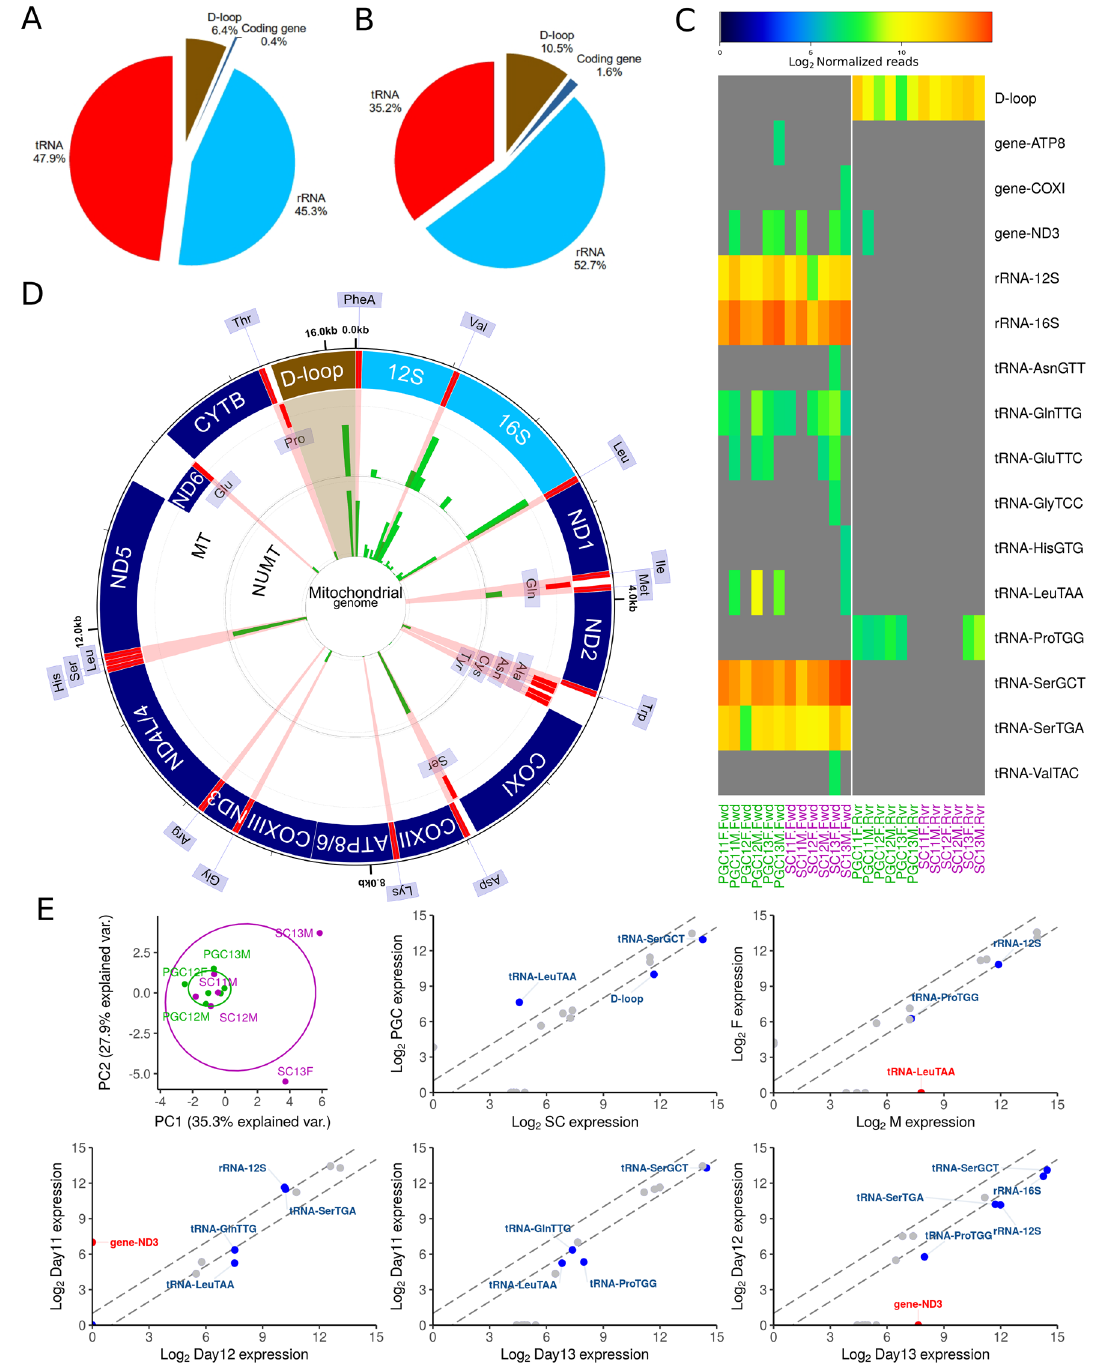
Figure 2. ( A ) Global feature distribution sequences of piRNAs matching regions related to the mitochondrial genome. ( B ) Global feature distribution of piRNA reads matching regions related to the mitochondrial genome. ( C ) Heatmap representing supervised hierarchical clustering overexpression of mito-piRNAs in forward (Fwd) and reverse (Rvr) orientation with respect to the mitochondrial genome in the samples analyzed. ( D ) Circular map of the level of expression of piRNAs mapping in the mitochondrial genome; MT and NUMT classified reads are plotted separately; tRNA and D-loop region are highlighted. ( E) PCA and comparative analysis between cell types: PGCs vs SCs; sex: F vs M; and among the three developmental days assessed (11.5, 12.5, and 13.5 dpc). PGC: primordial germ cells. SC: somatic cells. F: females. M: